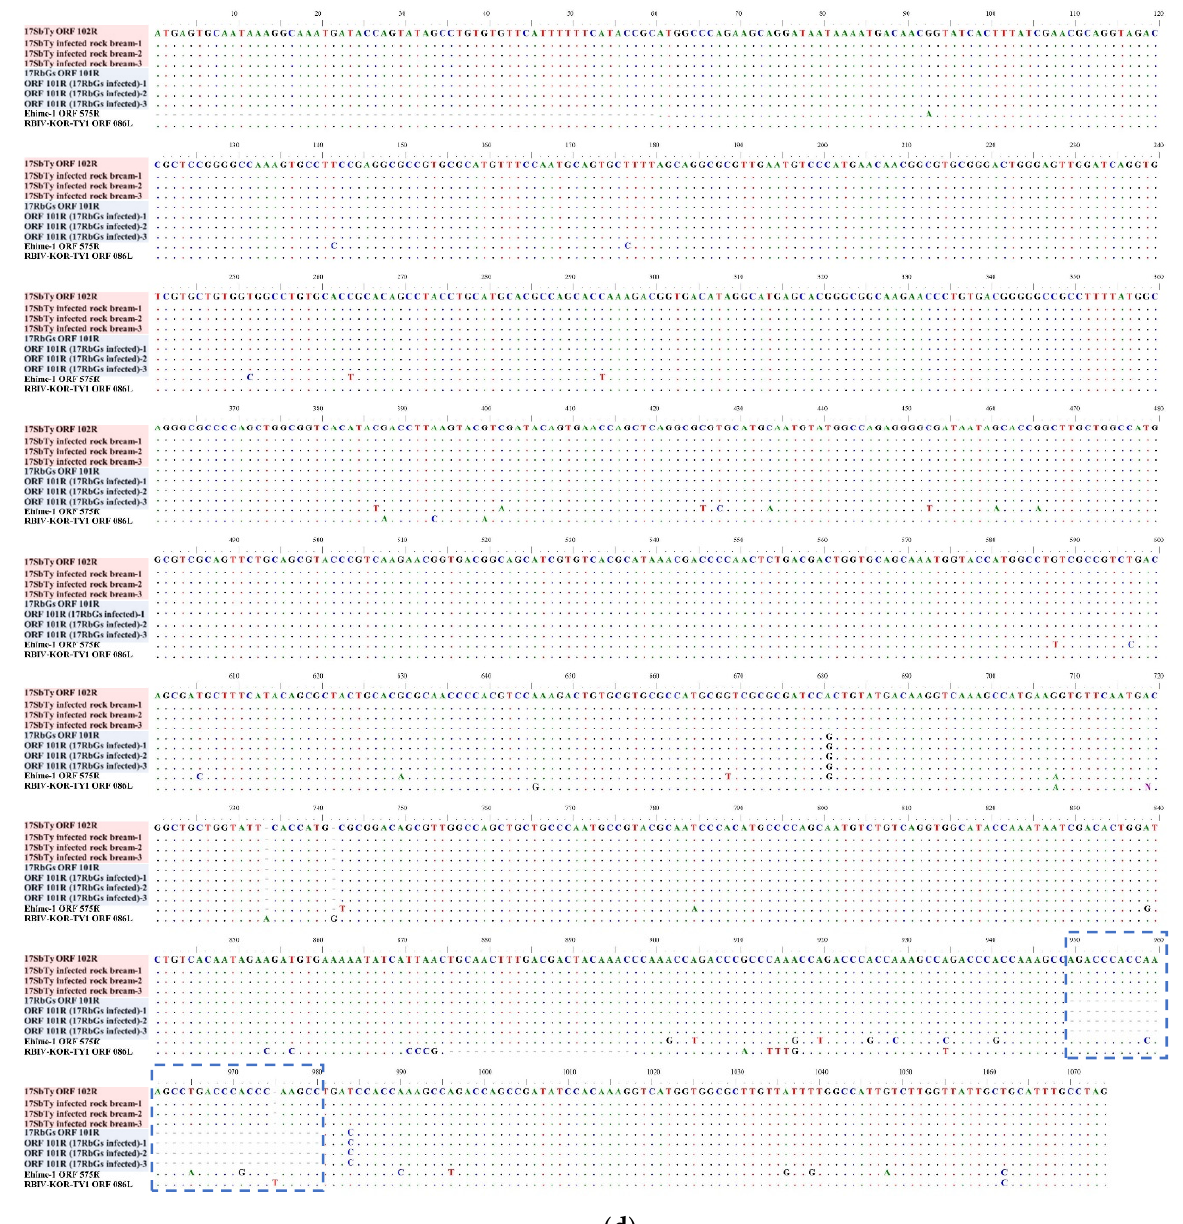
Figure A2. Comparison of nucleotide sequences covering the four insertion and deletions (InDels) in coding regions (ORFs ( a ) 014R, ( b ) 053R, ( c ) 054R and ( d ) 102R on the basis of 17SbTy isolate) between the cell-cultured isolates and viruses from RSIV-infected rock breams. The 17SbTy and 17RbGs from either cell-isolates or viruses from RSIV-infected rock bream are highlighted in red and blue boxes, respectively. The boxes consisting of blue dashed lines represent the InDel regions.